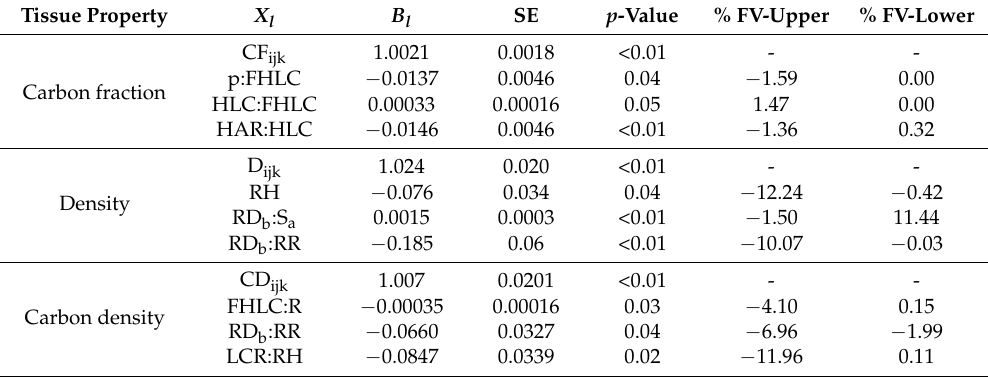
Table 6. Summary of LME model parameter fits from Equation (2). X l symbol descriptions can be found in Table 4. B l is the matrix of parameter estimates for the given covariate matrix X l . A p -value less than or equal to 0.05 indicates that the specified parameter estimate is significantly greater than zero. SE is the standard error of the parameter estimate shown in B l . The % FV-upper and % FV-lower columns give the result of evaluating a given term at the mean covariate value from Table 4 plus one standard deviation (upper) or minus one standard deviation (lower) and then dividing by the mean response